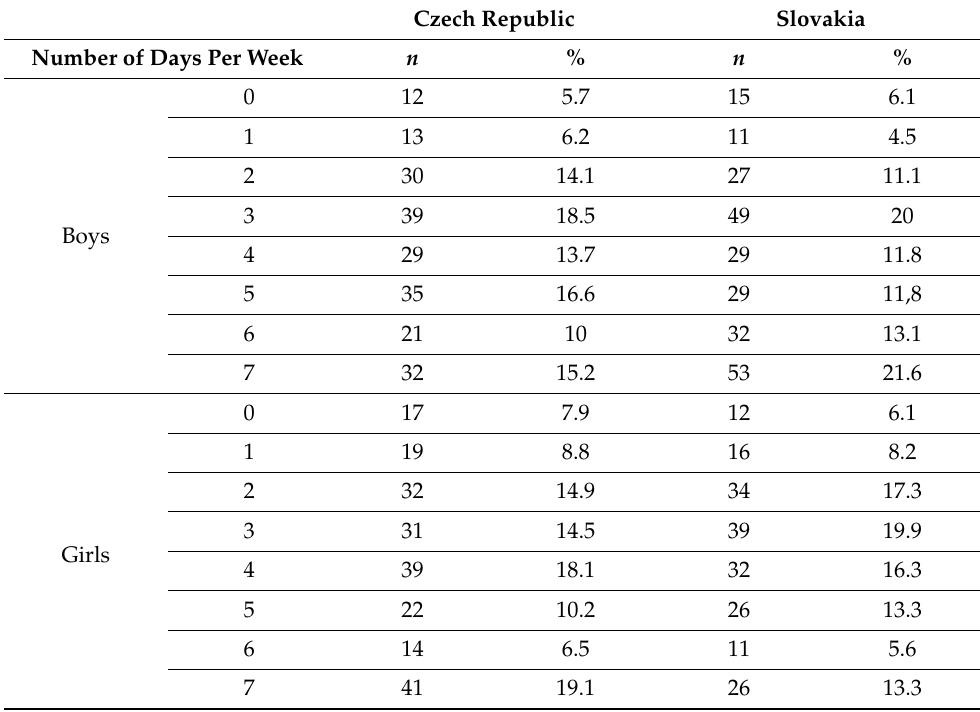
Table 3. Number of physically active days per week by country and gender.